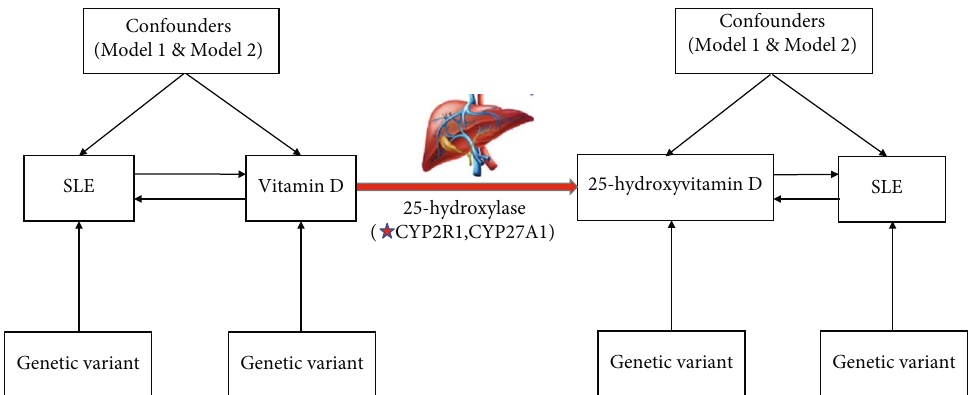
Figure 1: Overview of the experimental design of the present study. Model 1: SNPs associated with any potential confounders were not extracted. Model 2: SNPs associated with any potential confounders were extracted. SLE: systemic lupus erythematosus. Table 1: Details on GWAS predictive strength of IVs used in Mendelian randomization analyses. Study